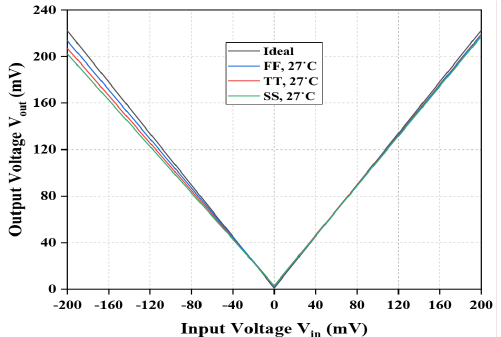
Figure 12. Process corner analysis of the proposed full-wave rectifier circuit.